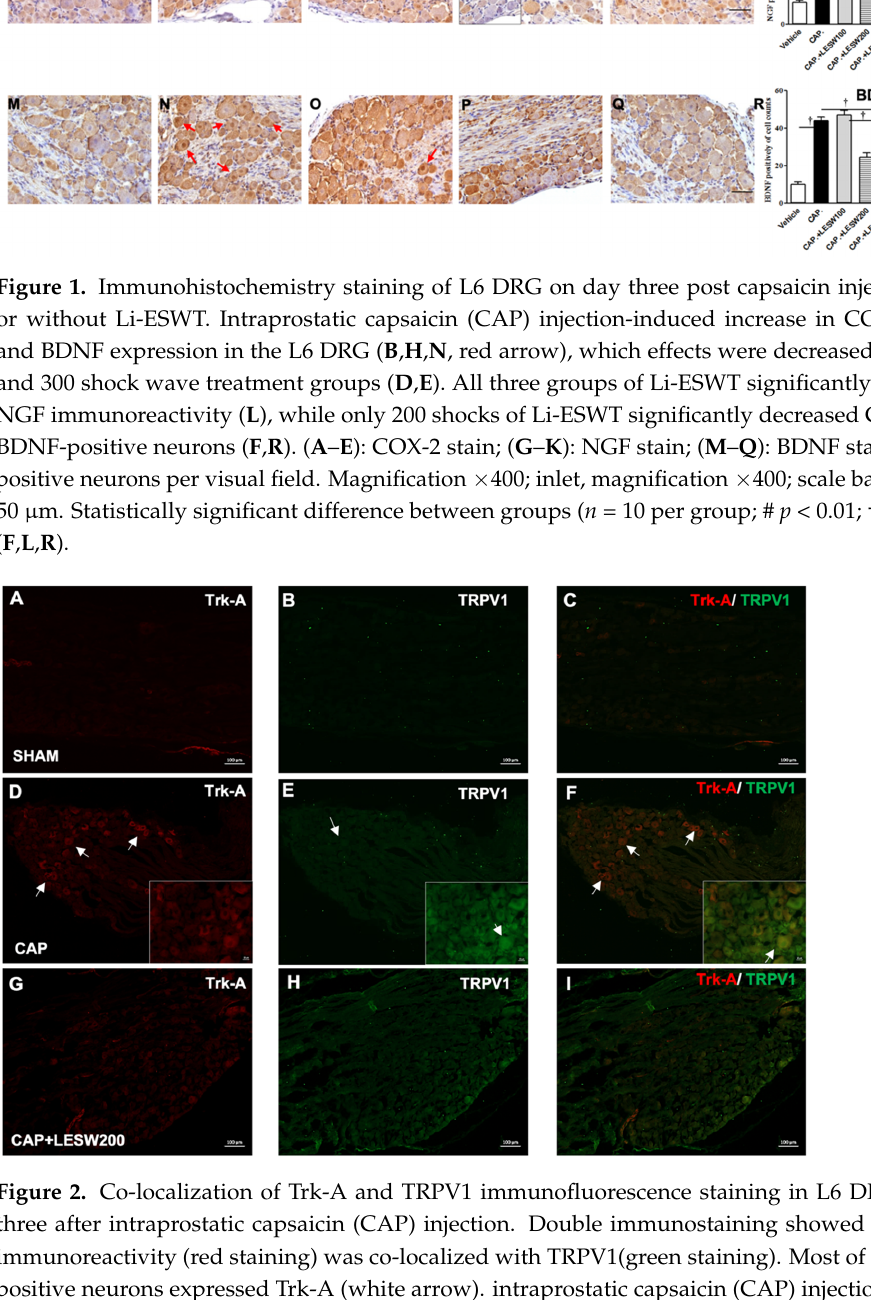
Figure 3. Immunofluorescence staining and Western blots analysis of L6 DRG three days after intraprostatic capsaicin (CAP) injection. Double immunostaining showed that Trk-A immunoreactivity (green staining) was co-localized with BDNF (red staining). Most of the BDNF- positive neurons expressed Trk-A (white arrows). Trk-A and BDNF immunoreactivity increased in intraprostatic capsaicin (CAP) injection group ( D , E , F ), which effects were attenuated by 200 and 300